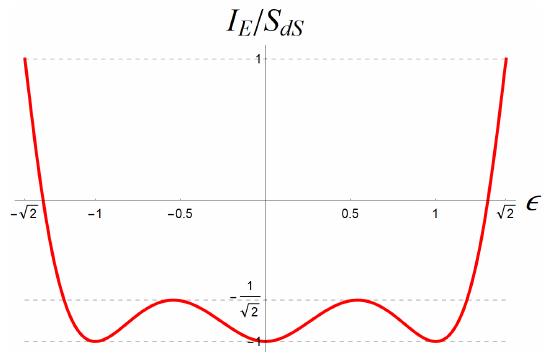
Figure 13: Euclidean action in units of S